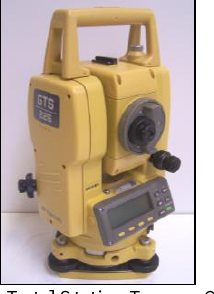
Figure 15. Total Station Topcon GTS-226